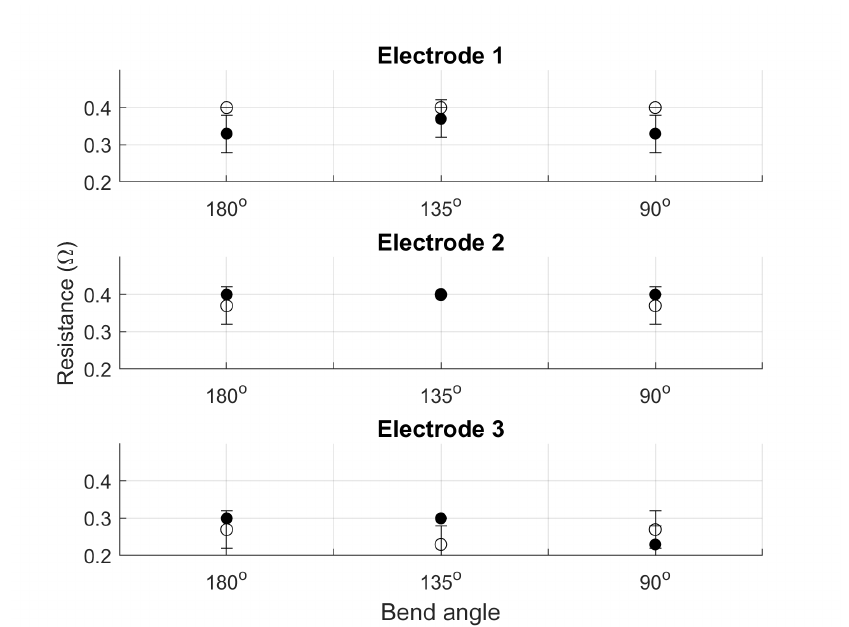
Figure 5. Vertical measurements are the filled circles, and horizontal measurements are the open circles. Many of the measurements returned the exact same results, so not all data points have visible standard